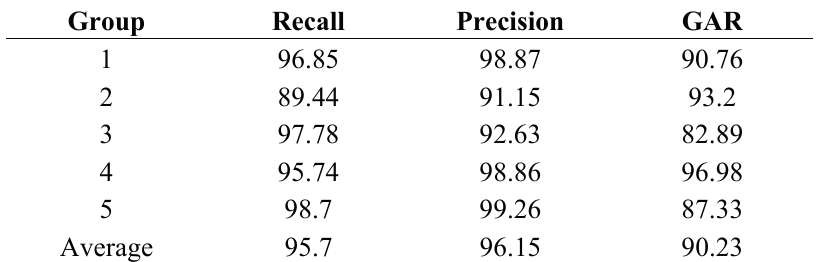
Table 1. Experimental Results based on Participant Groups (unit: %).